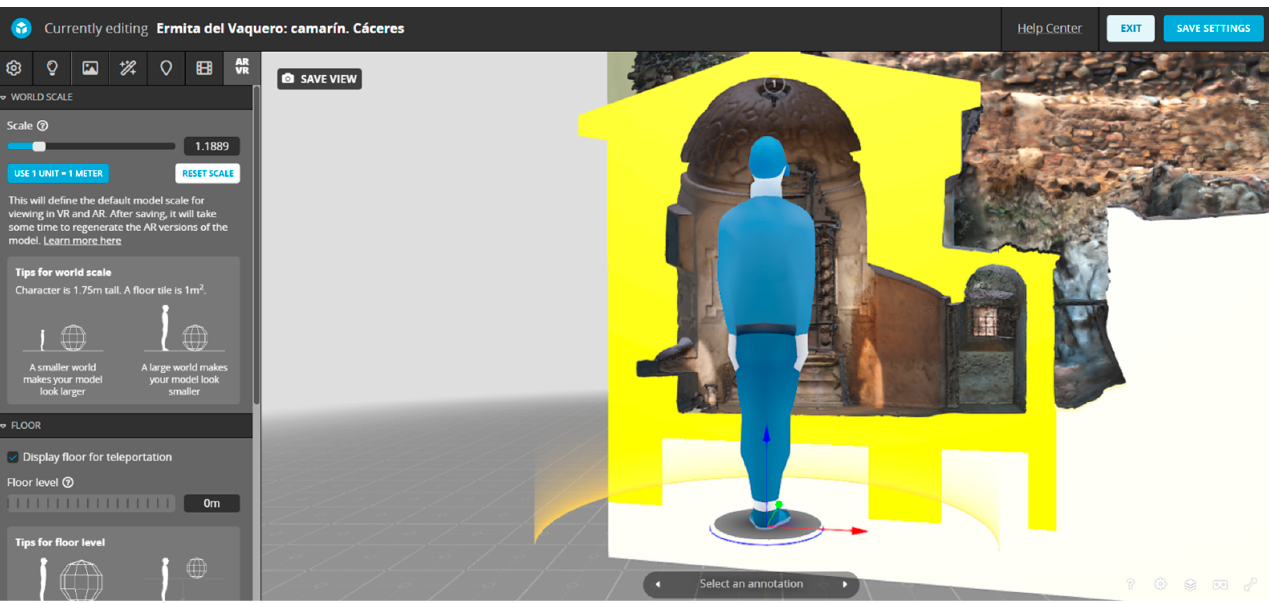
Figure 23. Sketchfab interface.